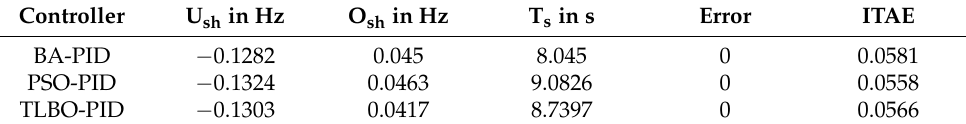
Table 10. Frequency response performances with FOPID tuned by different algorithms and designed by minimizing ITAE.